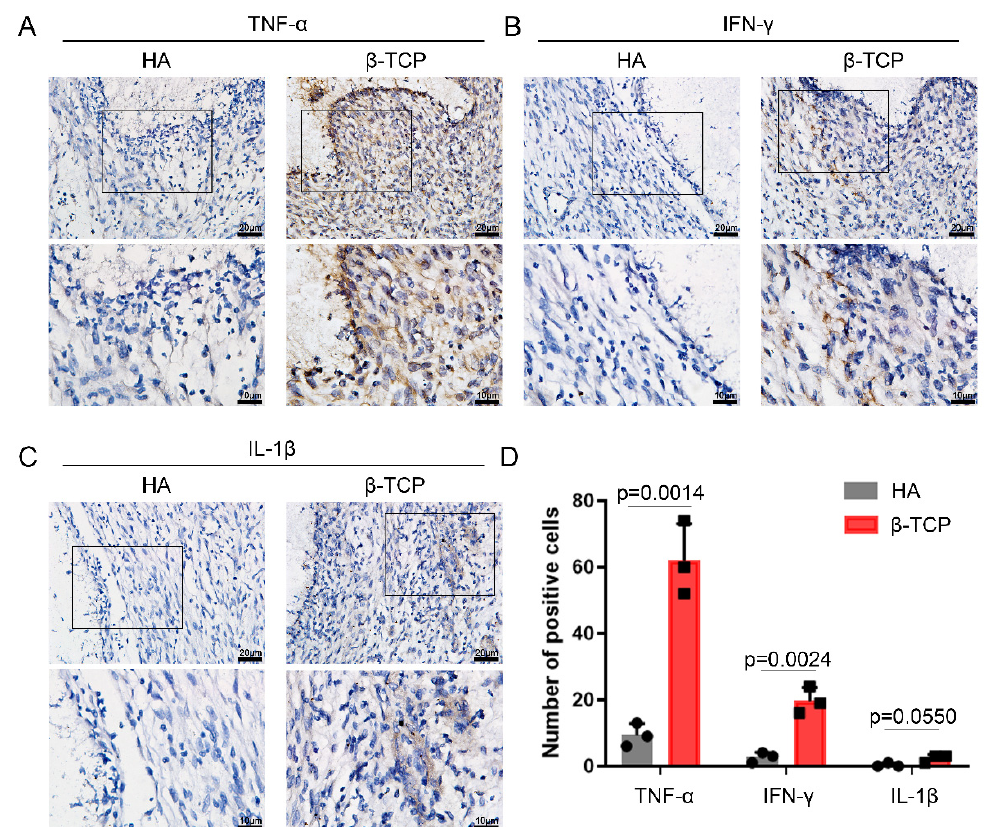
Figure 2. More inflammatory factors TNF- α and IFN- γ surrounding β -TCP than HA. IHC staining of ( A ) TNF- α , ( B ) IFN- γ , and ( C ) IL-1 β surrounding β -TCP and HA. ( D ) Semiquantitative comparison of positive expression. n = 3, black circles and blocks represent values from a single sample. The larger version of the black frame area in ( A – C ) were shown in the image below.